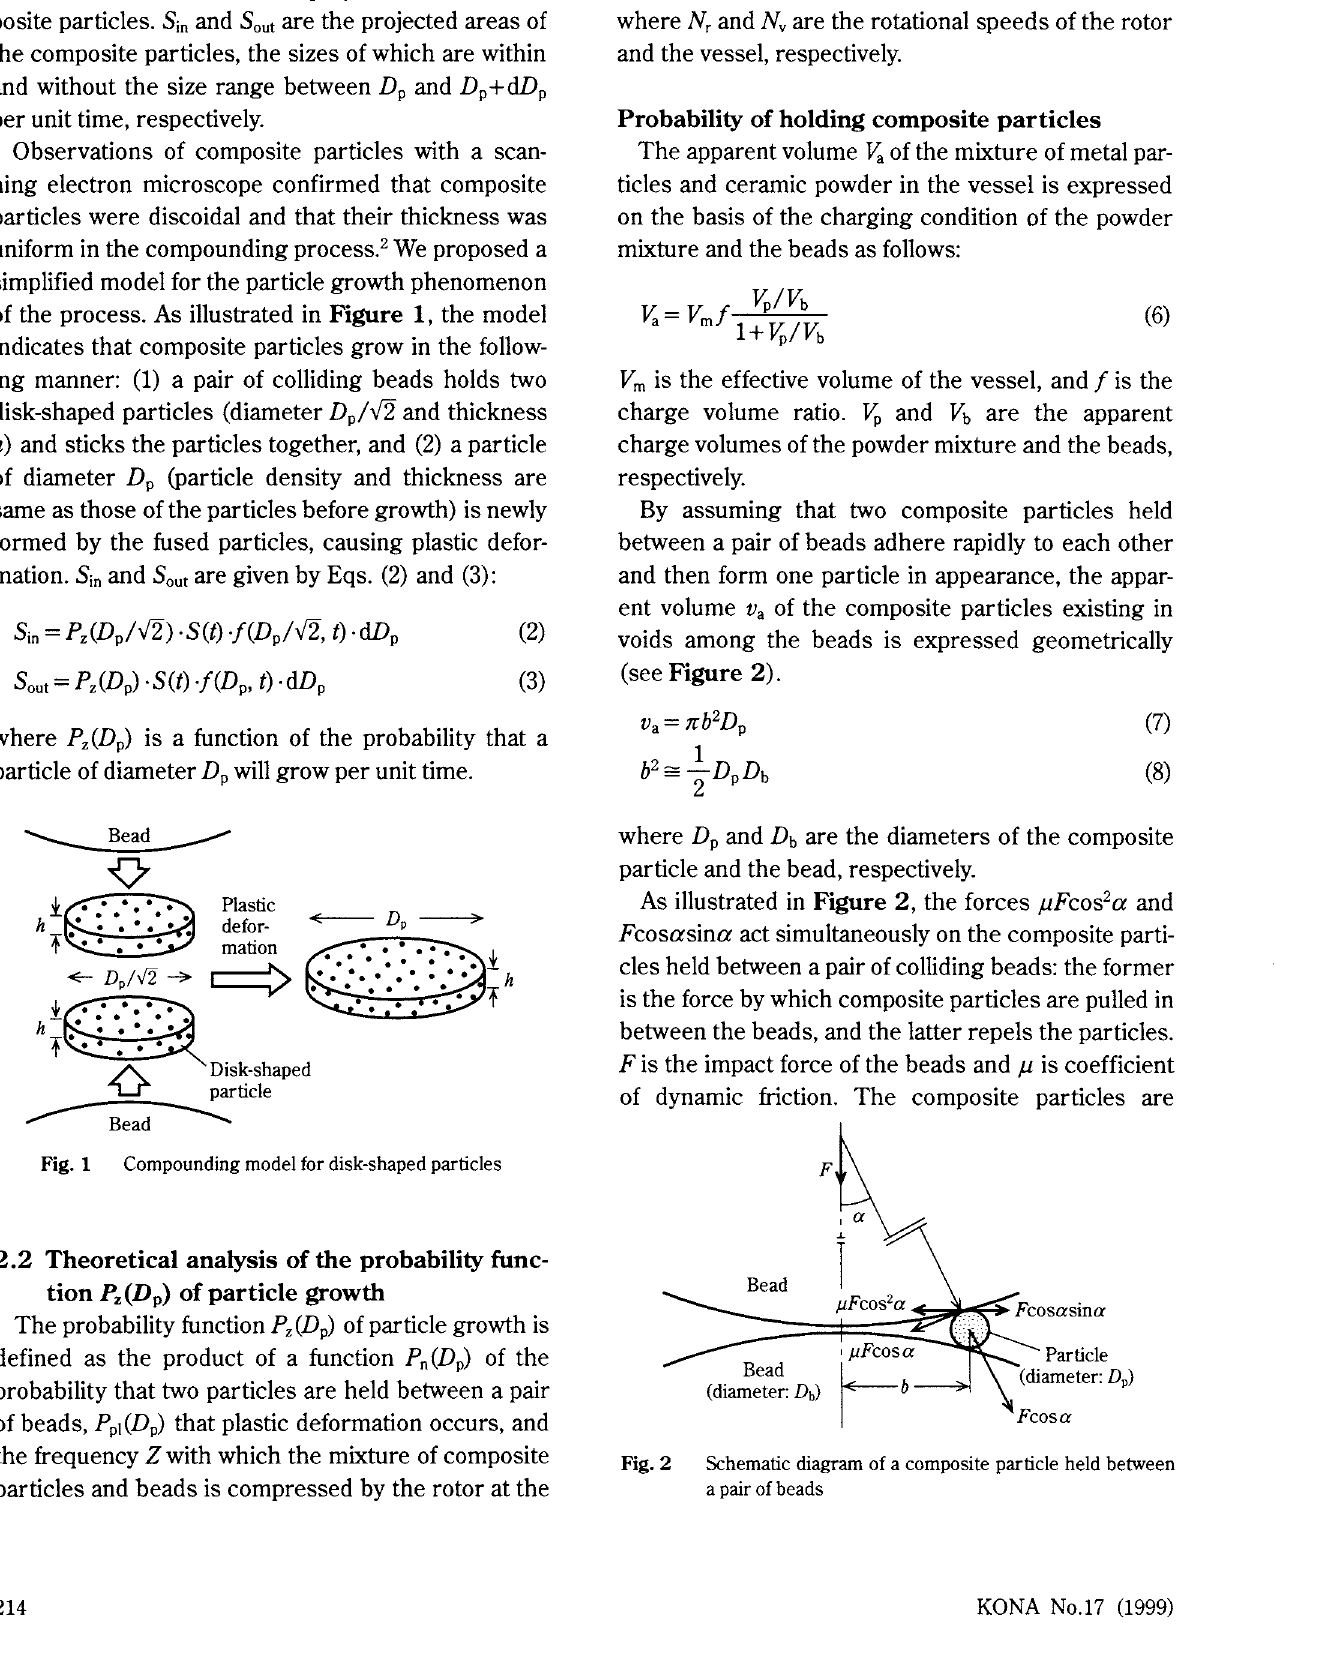
Schematic diagram of a composite particle held between a pair of beads